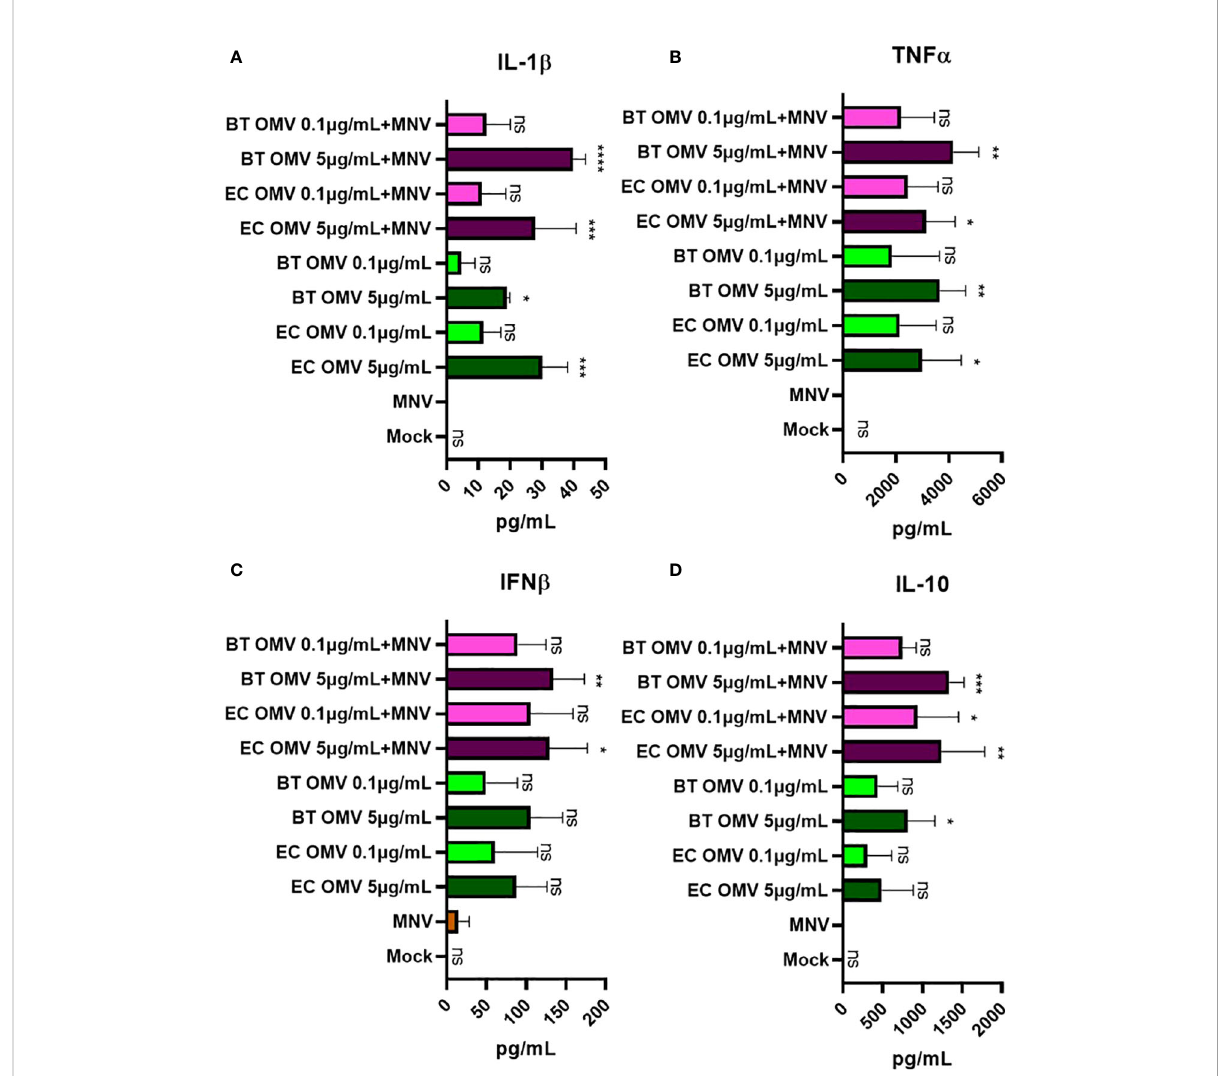
FIGURE 7 Alteration of the cytokine level secreted by macrophages on MNV-OMV co-inoculated. ELISA was used to measure the quantity of secreted cytokines in BMDM supernatant (n=3) obtained after treatments with mock, MNV, E cloacae OMVs, B thetaiotaomicron OMVs, MNV+ E. cloacae OMVs, or MNV+ B thetaiotaomicron OMVs. A high concentration (5 m g/mL) and a low concentration (0.1 m g/mL) of OMVs were used. The following cytokines were measured (A) IL-1 b , (B) TNF a , (C) IFN b , and (D) IL-10, and statistical signi fi cance was calculated relative to MNV only infection supernatants. T-test with Welsch ’ s correction was done to detect signi fi cant changes in protein secretion. (*=p<0.05, **=p<0.01, ***=p<0.001, ****=p<0.0001). Ns= not signi fi